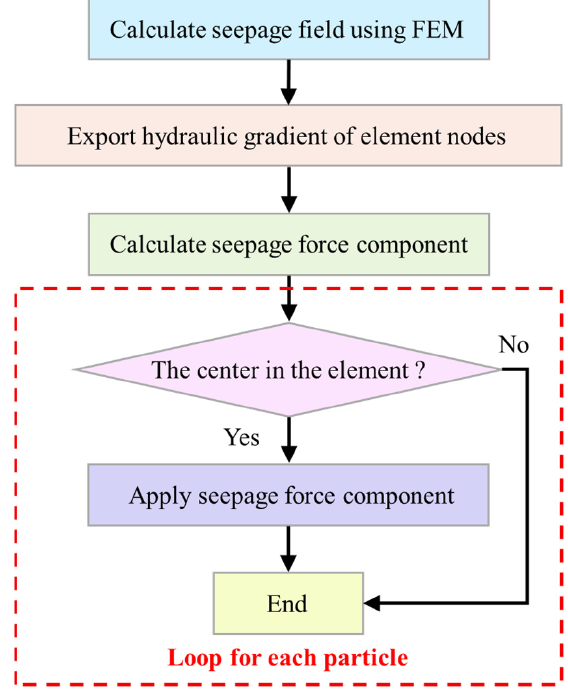
Figure 11. Procedure of seepage force application.